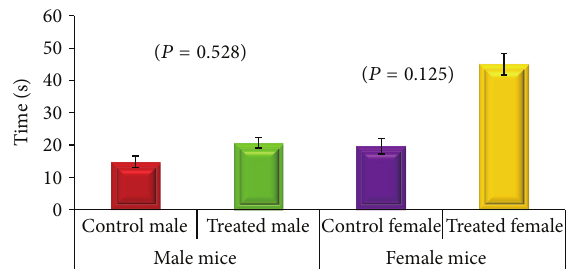
Figure 1: Comparison of rota rod test results control male/female with their respective GABA B receptor antagonist (CGP 35348) treated male and female albino mice. Data is expressed as mean ± standarddeviation. 𝑃 valuesindicatetheresultsoftwo-sample 𝑡